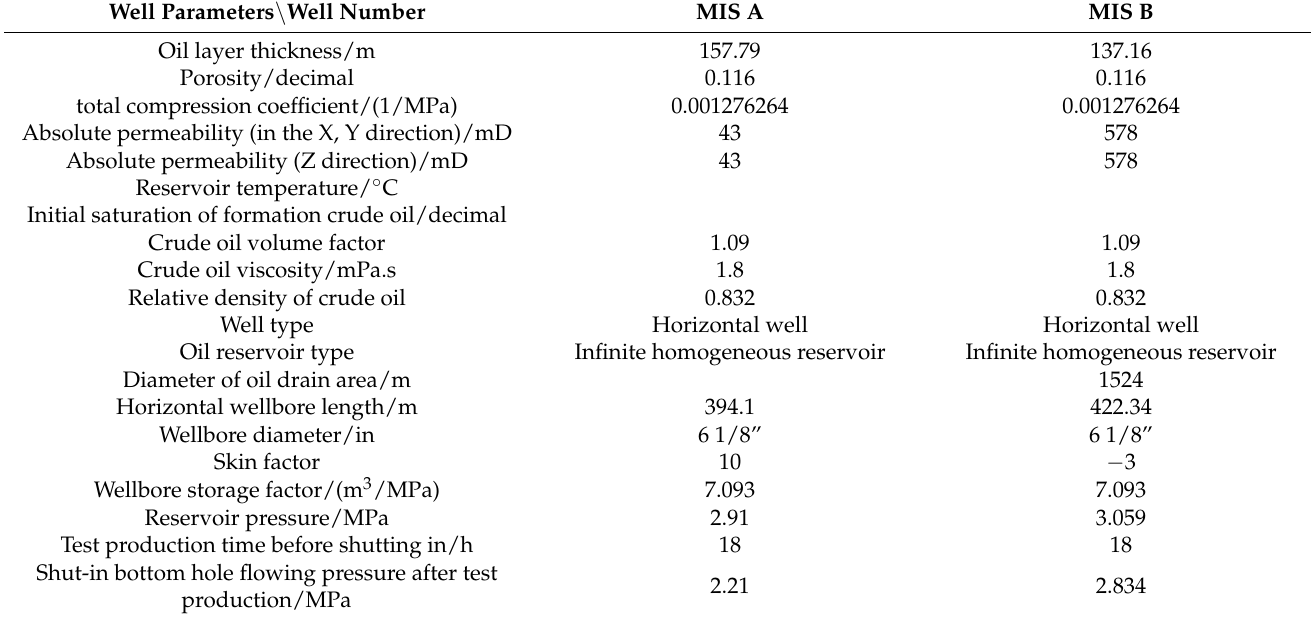
Table 4. Basic parameters of oil reservoir and two horizontal wells.